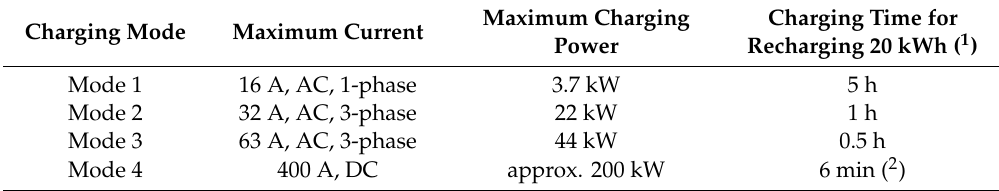
Table 1. EV charging modes according to IEC 61851-1